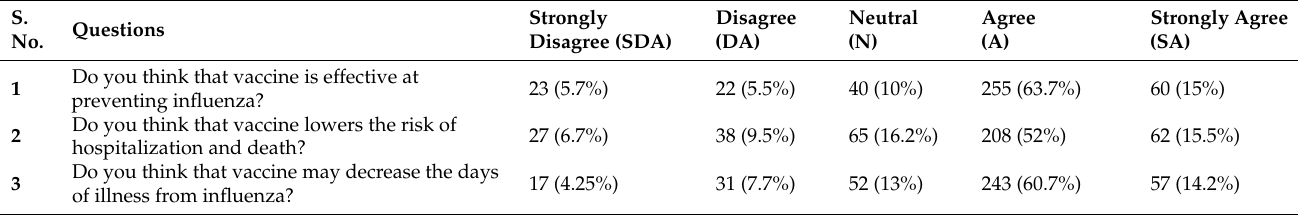
Table 4. Health care professionals’ attitude towards influenza